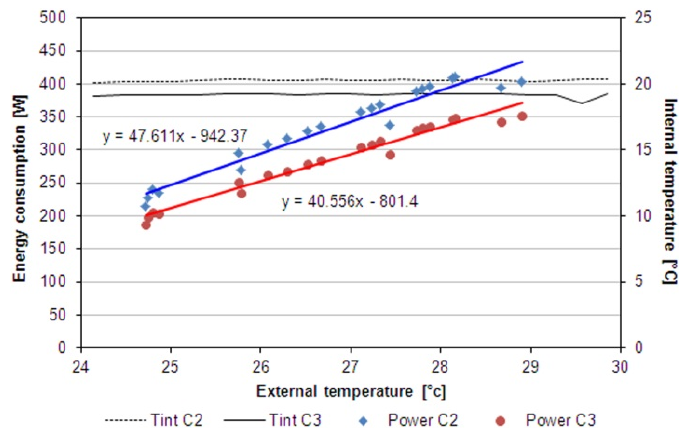
Figure 12. Energy Signature of cooling configuration.